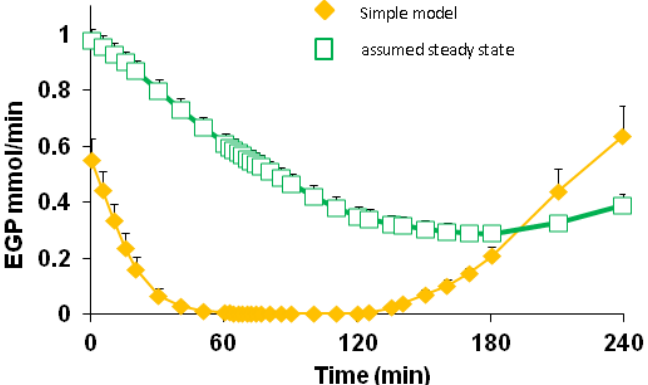
Figure 3. Comparison of calculated endogenous glucose production (EGP) based on either the Simple model, that allows for return of label to primary pool, or assuming steady state, where no allowance for label return is included. Data from the M diet, but the other diets gave similar patterns (not shown). The difference in calculated EGP at time 0 is because the Simple model allowed for the slow decline in plasma glycaemia during the 2 h fasting prior to the dextrose challenge. Differences in the decline and recovery of EGP over time again reflect that the Simple model allows for the return of label to the plasma pool while the steady state approach does